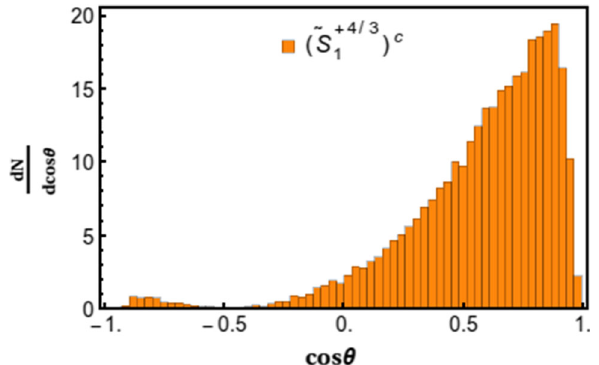
Fig. 7 Angular distribution for the associated production of recon- structed 70 GeV leptoquark (cid:8) S c relative to photon angle (θ) made with √ 1 s = 318 . 12 GeV and L int = 100 fb − 1 in the rest electron beam, at frame of